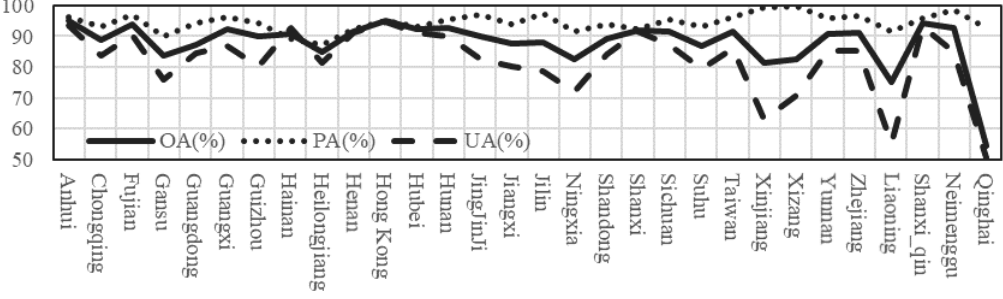
Figure 14. The overall accuracy, producer’s accuracy and user’s accuracy for each province. JingJinJi area includes Hebei province, Beijing and Tianjin; SuHu area includes Shanghai and Jiangsu province.